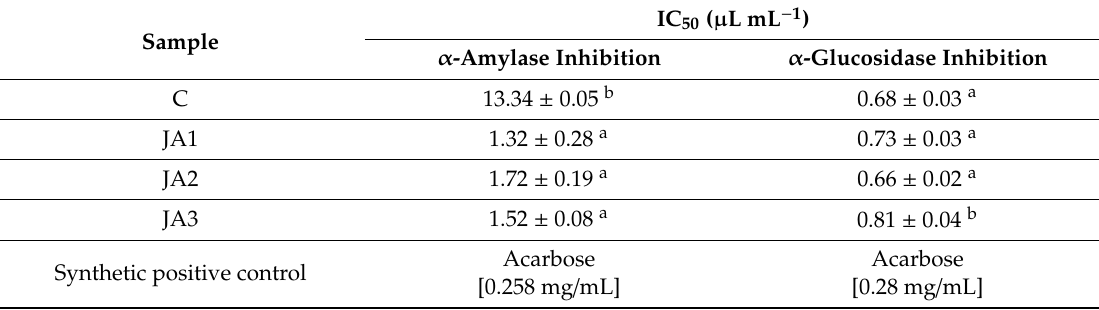
Table 2. E ff ect of jasmonic acid elicitation on α -amylase and α -glucosidase inhibitory activity of essential oil from